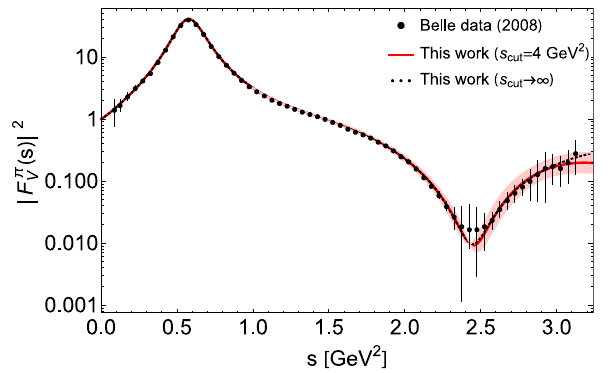
Fig. 3 Belle measurement of the absolute value squared of the pion vector form factor (black filled circles) [31] as compared to our fit results as presented in Table1 for s cut = 4 GeV 2 (red solid line) and for s cut → ∞ (black dotted